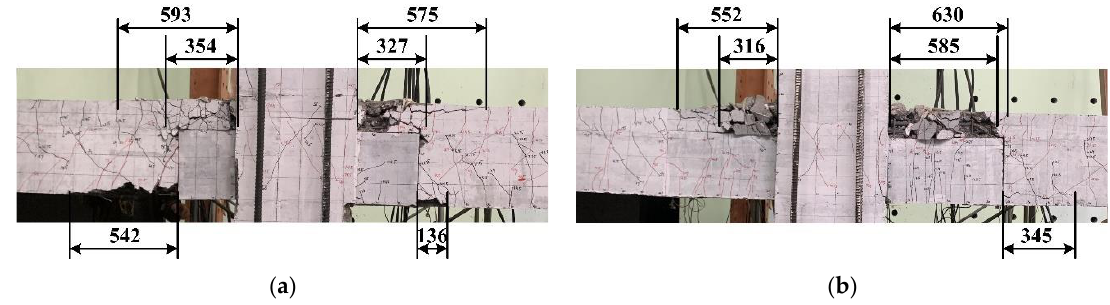
Figure 12. Length of plastic hinges of the specimens (mm). ( a ) Specimen PU1, ( b ) Specimen PU2. Table 6. Length of plastic hinges of specimens (mm)